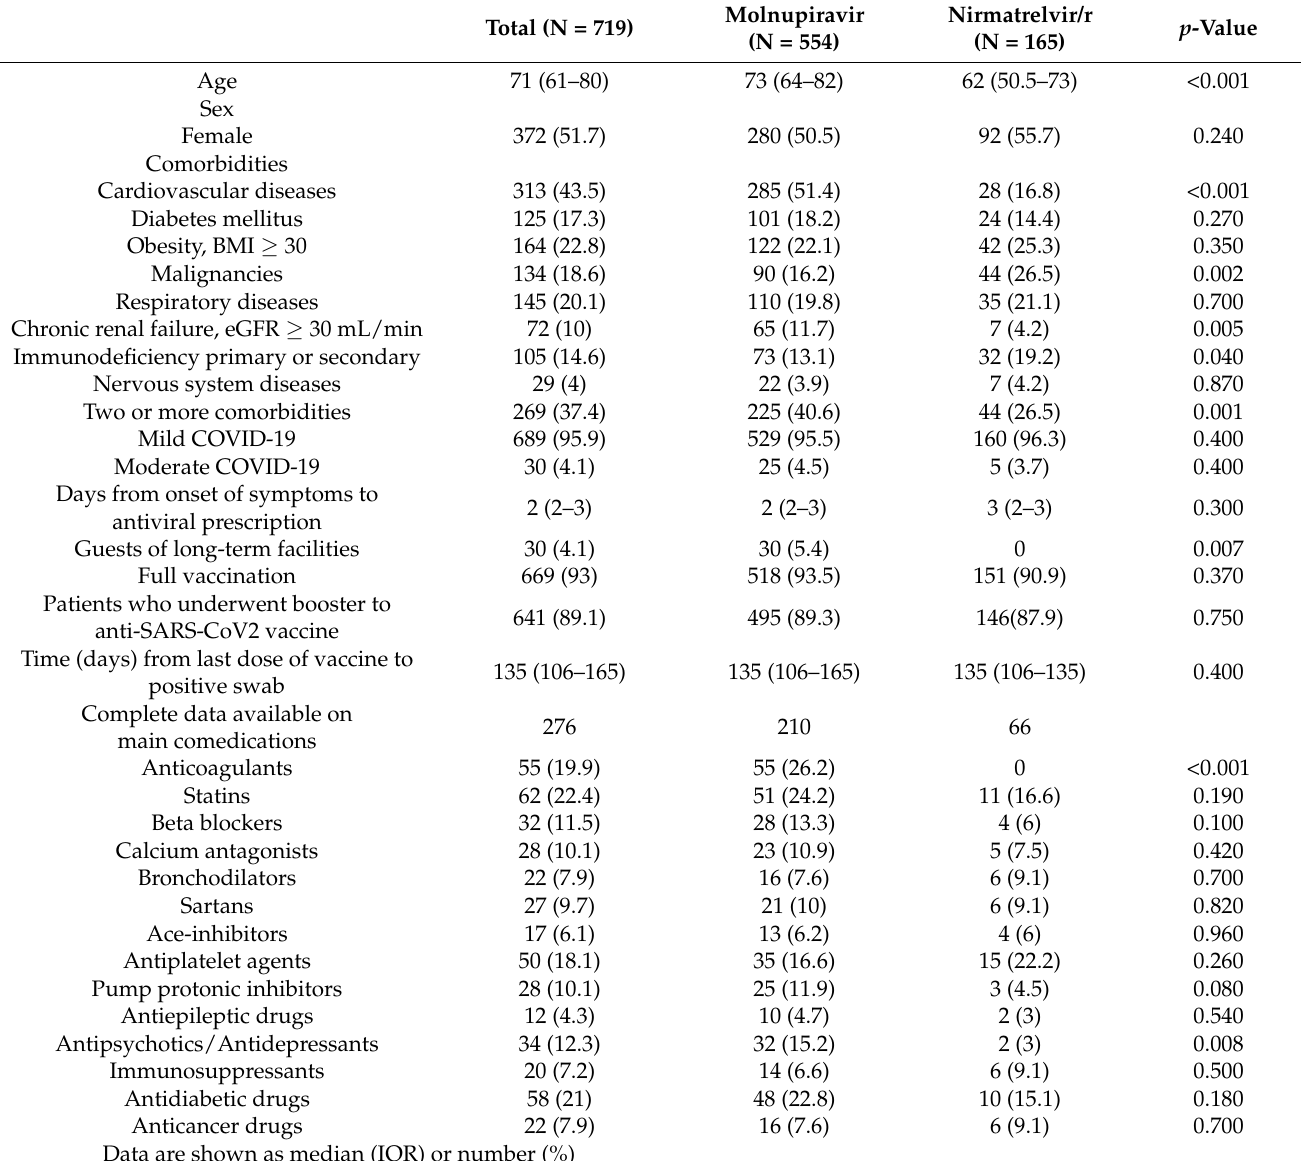
Table 1. Clinical characteristics according to antiviral